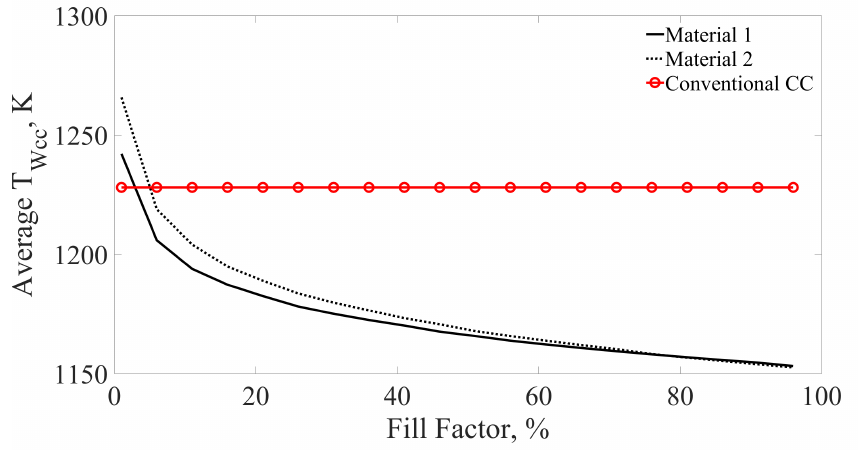
Figure 14. Combustor average inner wall temperature as a function of the TEG fill factor. The temperature of a conventional combustion chamber wall is also presented for